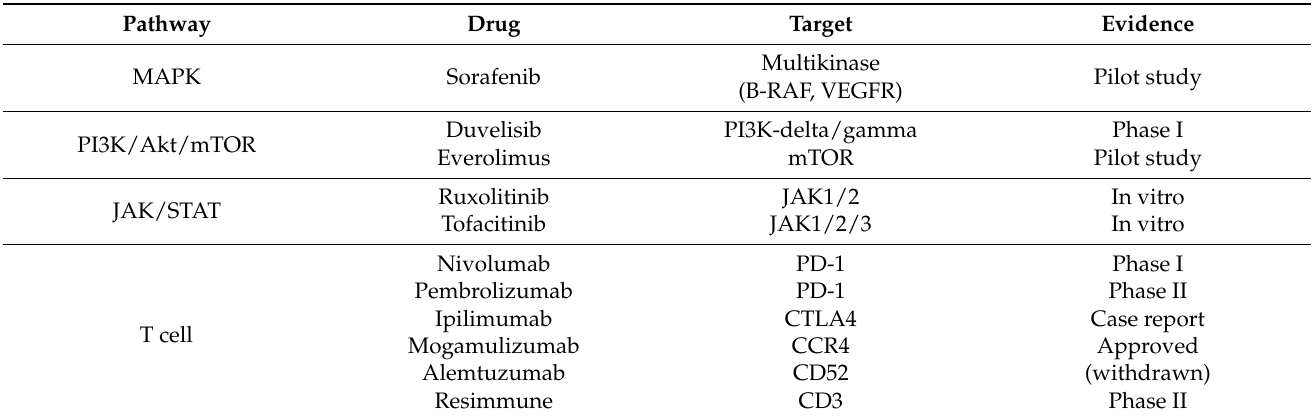
Table 2. Antigen targets and clinical trials to treat cutaneous T cell lymphoma with antibody–drug